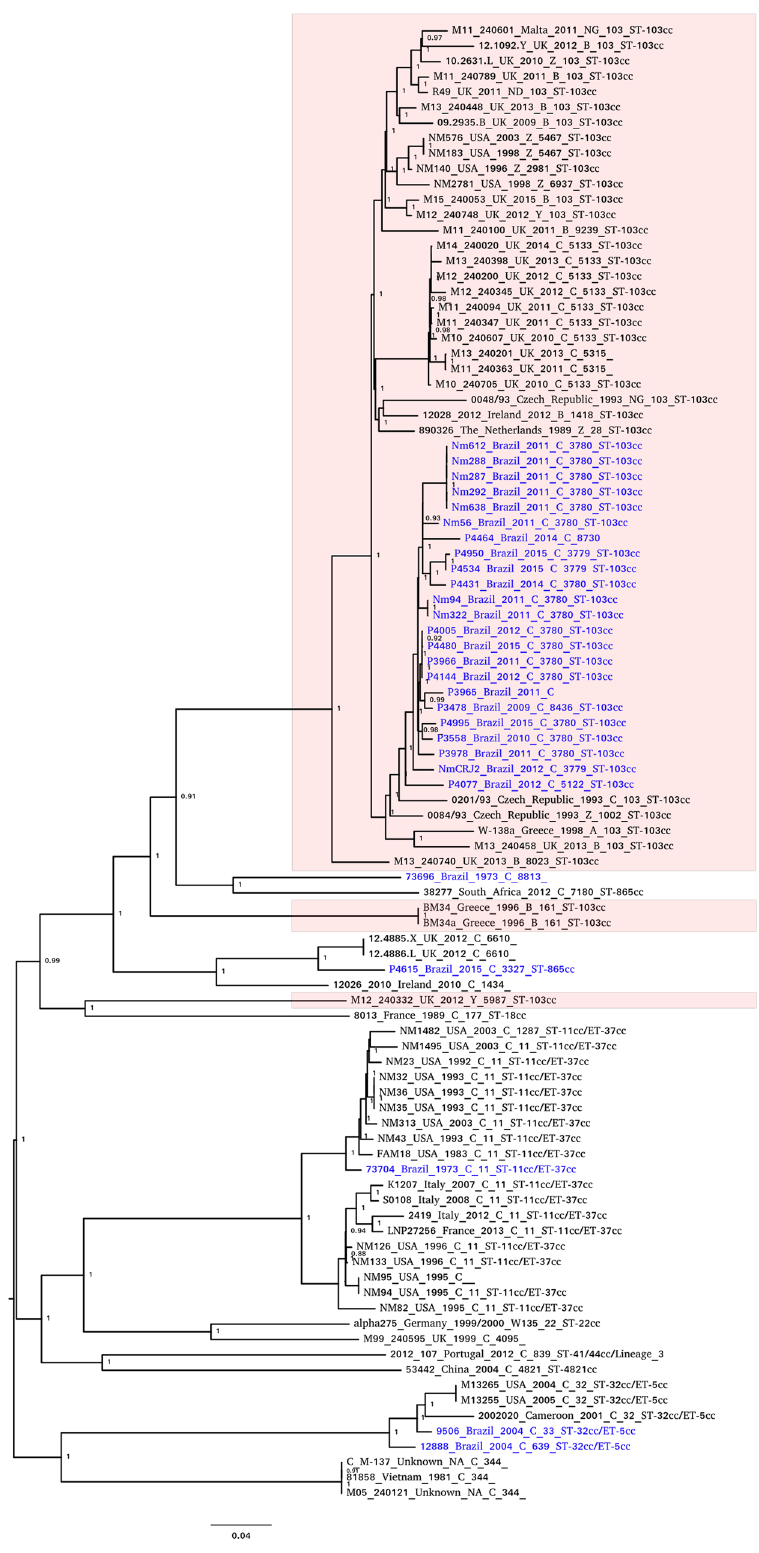
Figure 1. Genome phylogeny overview of N. meningitidis CC103 complex and close relatives. The phylogeny was determined considering the core genome alignment and maximum likelihood reconstruction phylogeny by using Parsnp program implemented in Harvest suite 55 . Highlighted boxes indicate the genomes assigned as CC103 complex. Brazilian MenC strains are depicted in